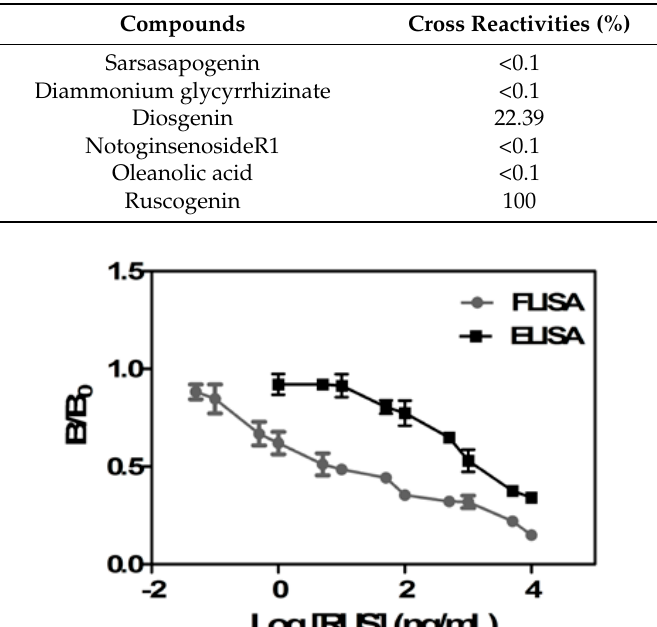
Table 1. Comparison of several parameters of the competitive FLISA and ELISA for RU.